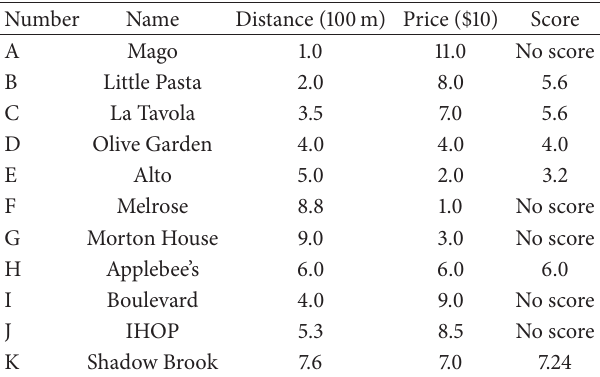
Table 1: The list of restaurants in Example